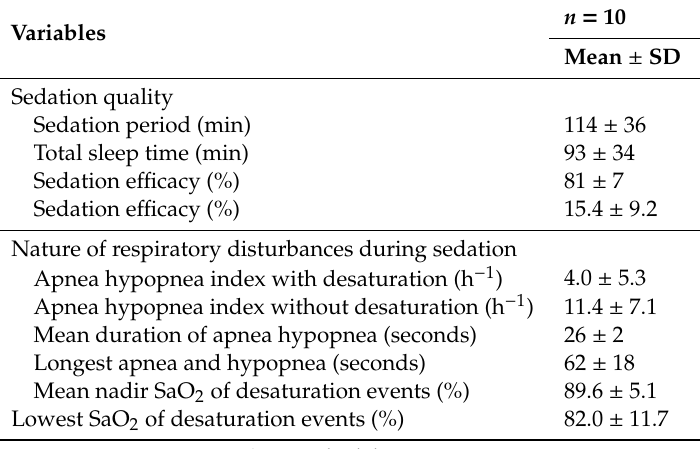
Table 2. Details of the sedation and nature of respiratory